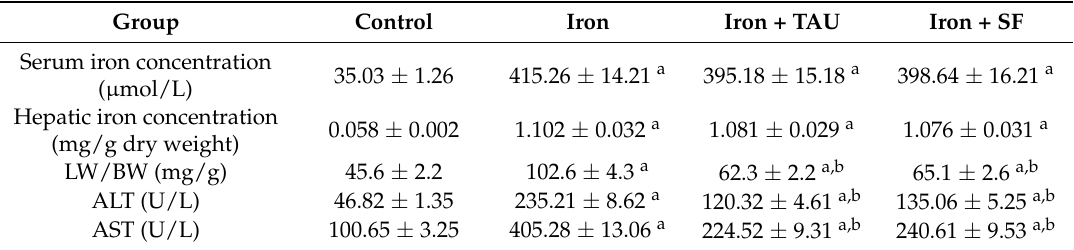
Table 1. Effect of TAU or SF on the serum and hepatic iron concentration, liver-to-body weight ratio, serum levels of ALT and AST in iron-overloaded